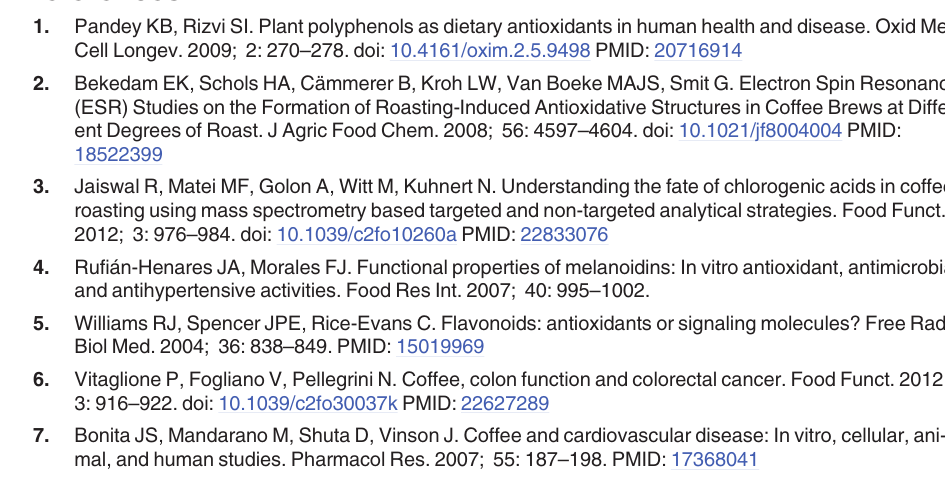
S1 Table. Numerical EC50 values corresponding to the graphical data in Fig 5 (main text). Data represent the mean and SEM obtained from three brews prepared and assayed